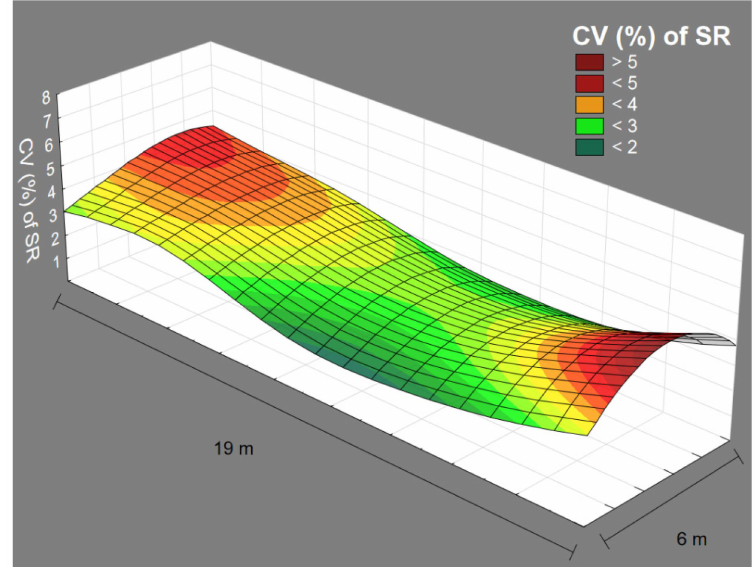
Figure 9. Spatial distribution of precision (CV) in surface rugosity (SR) values amongst three models derived from replicate photogrammetric modelling of a 120 m 2 area of benthic habitat. Error in SR values was calculated from the same spatial area of each aligned model based on a grid of non-overlapping virtual square quadrats of 1 m 2 area laid over the model